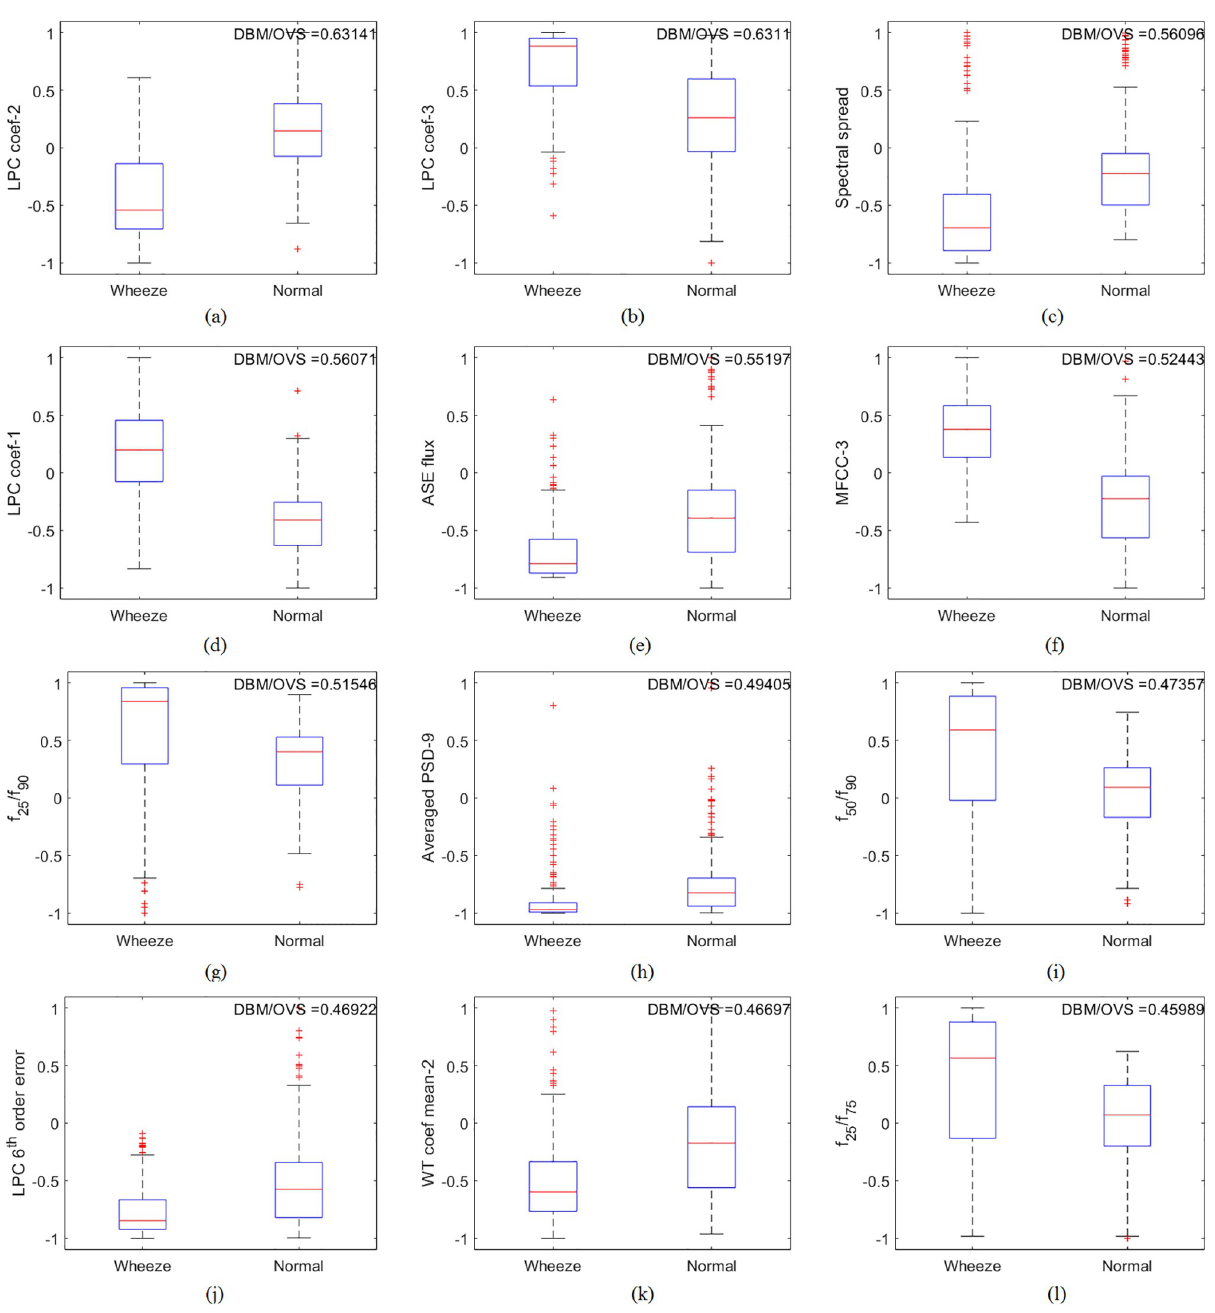
Fig 5. Box Plot of (a) LPC coef-2, (b) LPC coef-3, (c) Spectral spread, (d) LPC coef-1, (e) ASE flux, (f) MFCC-3, (g) f 25 / f 90 , (h) Averaged PSD-9, (i) f 50 /